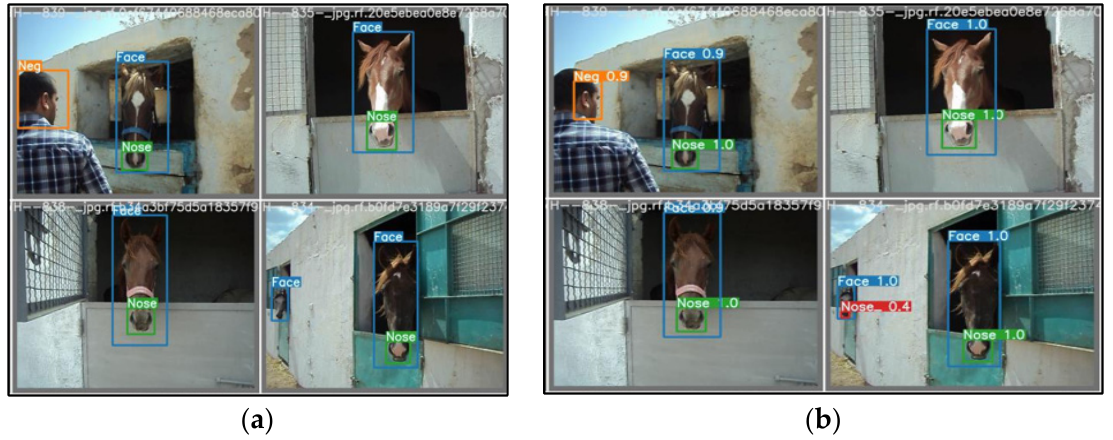
Figure 6. Testing Object Detection Model: in ( a ) are the annotated images of the test set, and in ( b ) are the bounding boxes predicted by the Yolo object detection model trained by transfer learning.